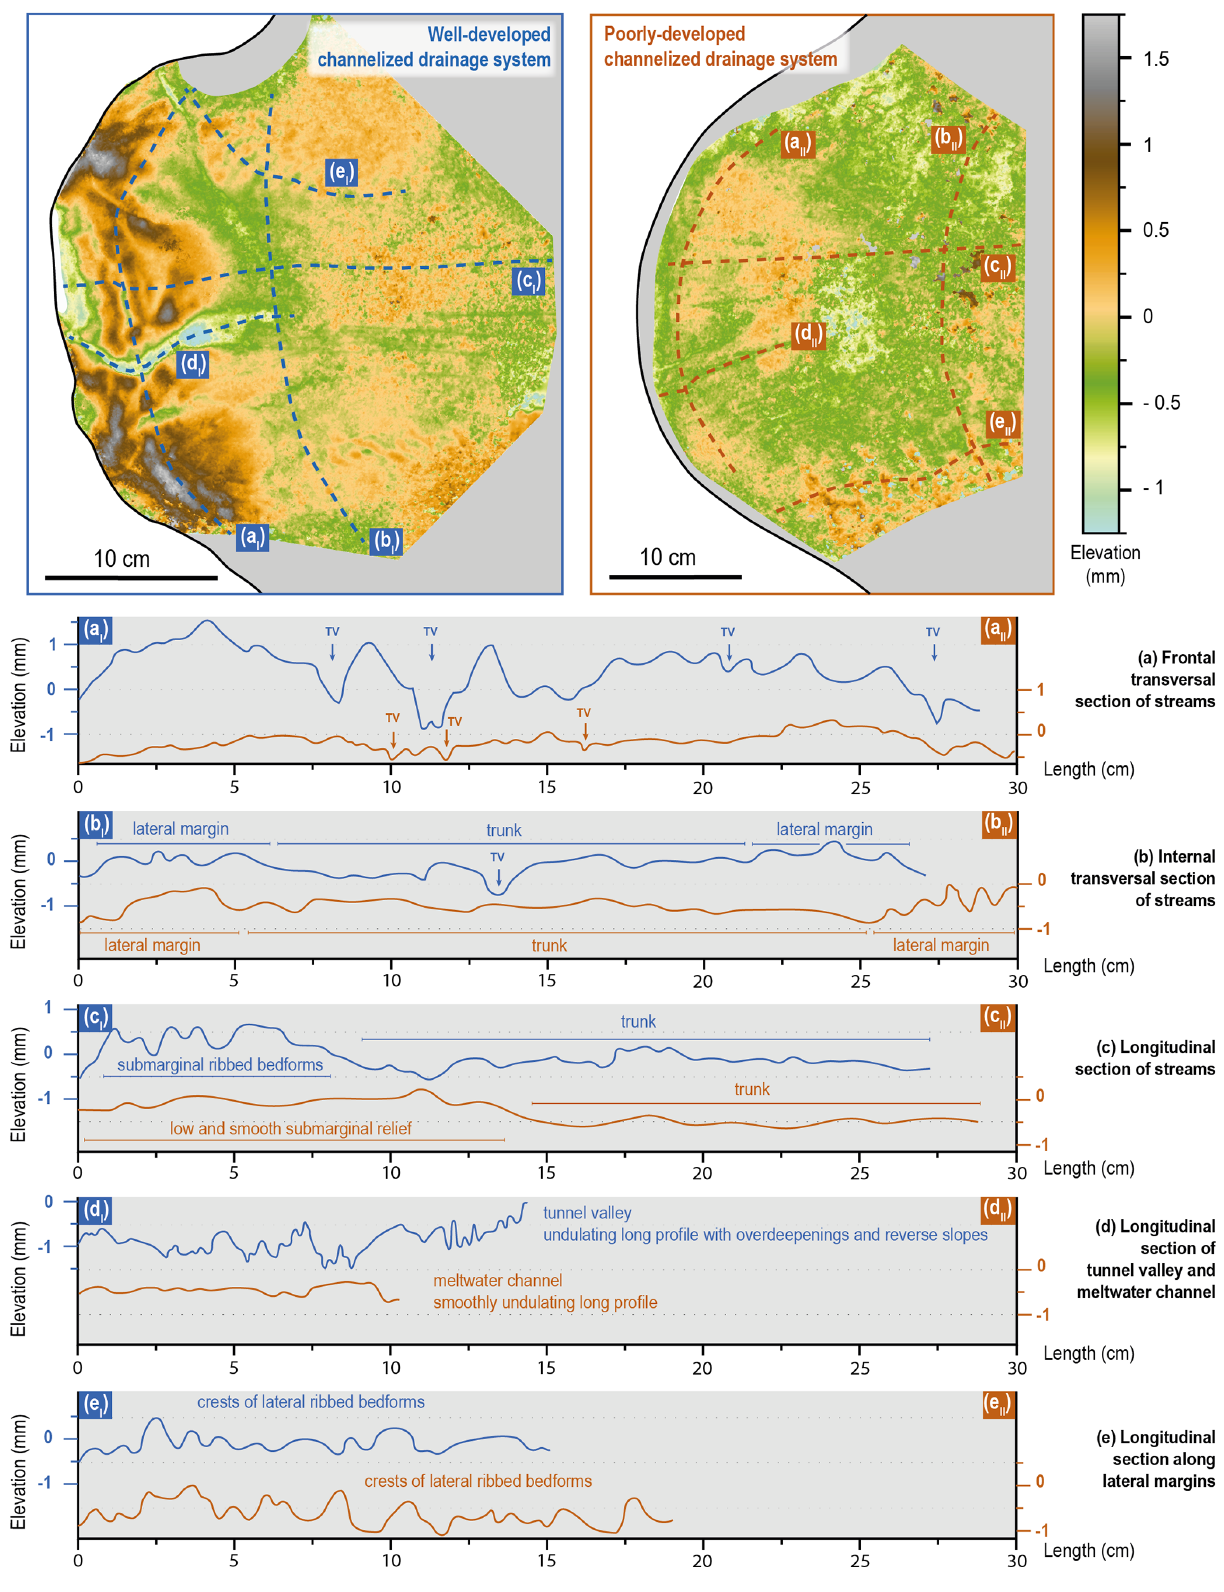
Figure 10. DEMs of the bed surface beneath the lobes of the silicone streams at the final stage of Experiment 10 (blue) and Experiment 14 (brown). Ten elevation profiles (a–e) within the lobes are drawn to compare the morphological imprint beneath the two types of